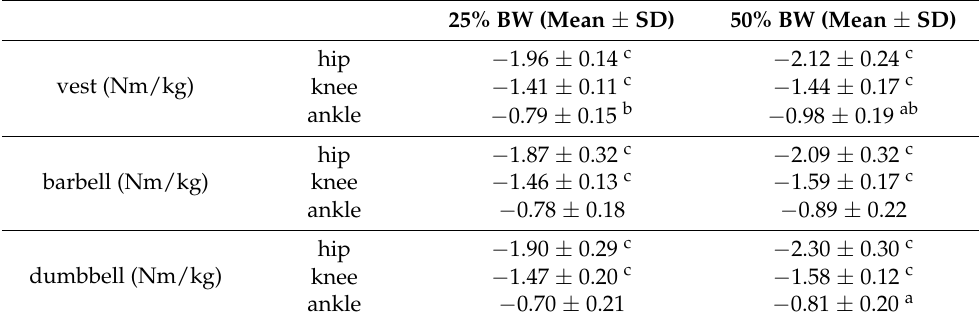
Table 2. Peak joint moments of hip, knee, and ankle at 25% BW and 50% BW.